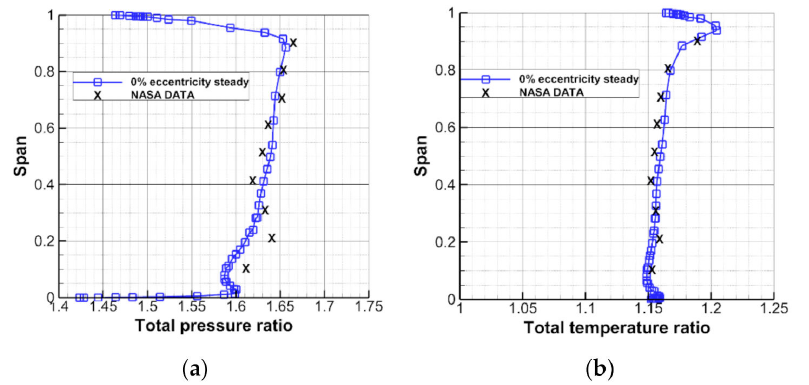
Figure 8. Comparison of experimental and calculated spanwise distributions of total pressure ratio, total temperature ratio at the point of NPE. ( a ) Spanwise distribution of total pressure ratio; ( b ) spanwise distribution of total temperature